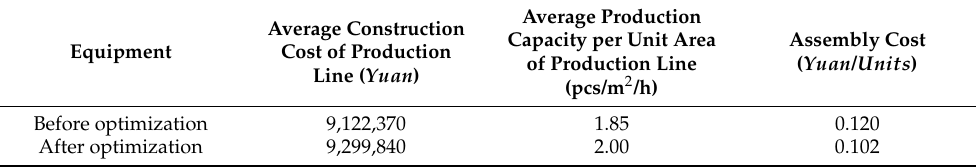
Table 8. Optimization